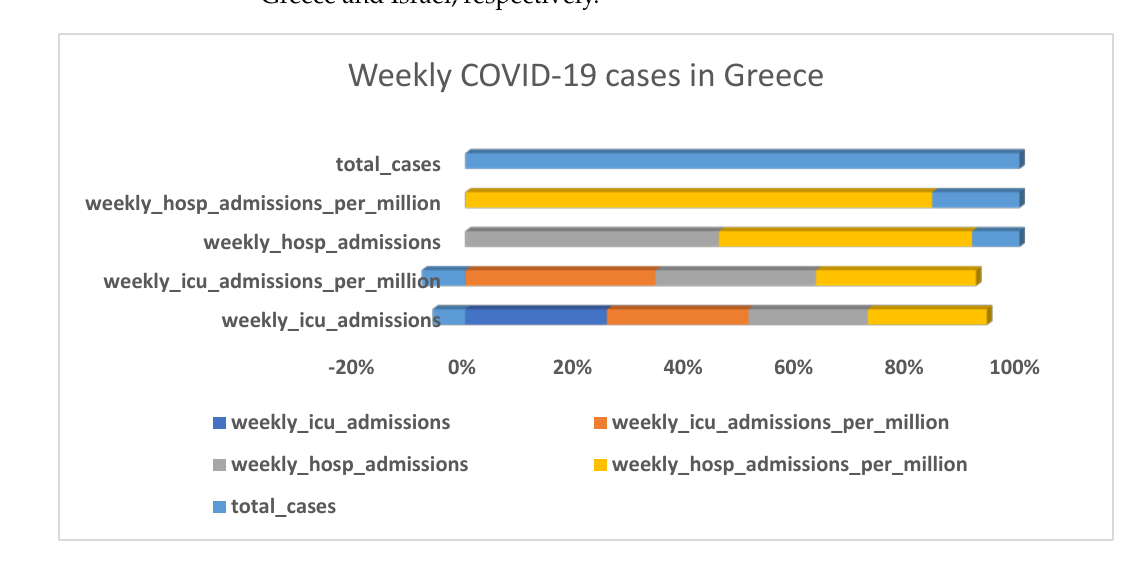
Figure 2. Weekly COVID-19 cases in Greece.